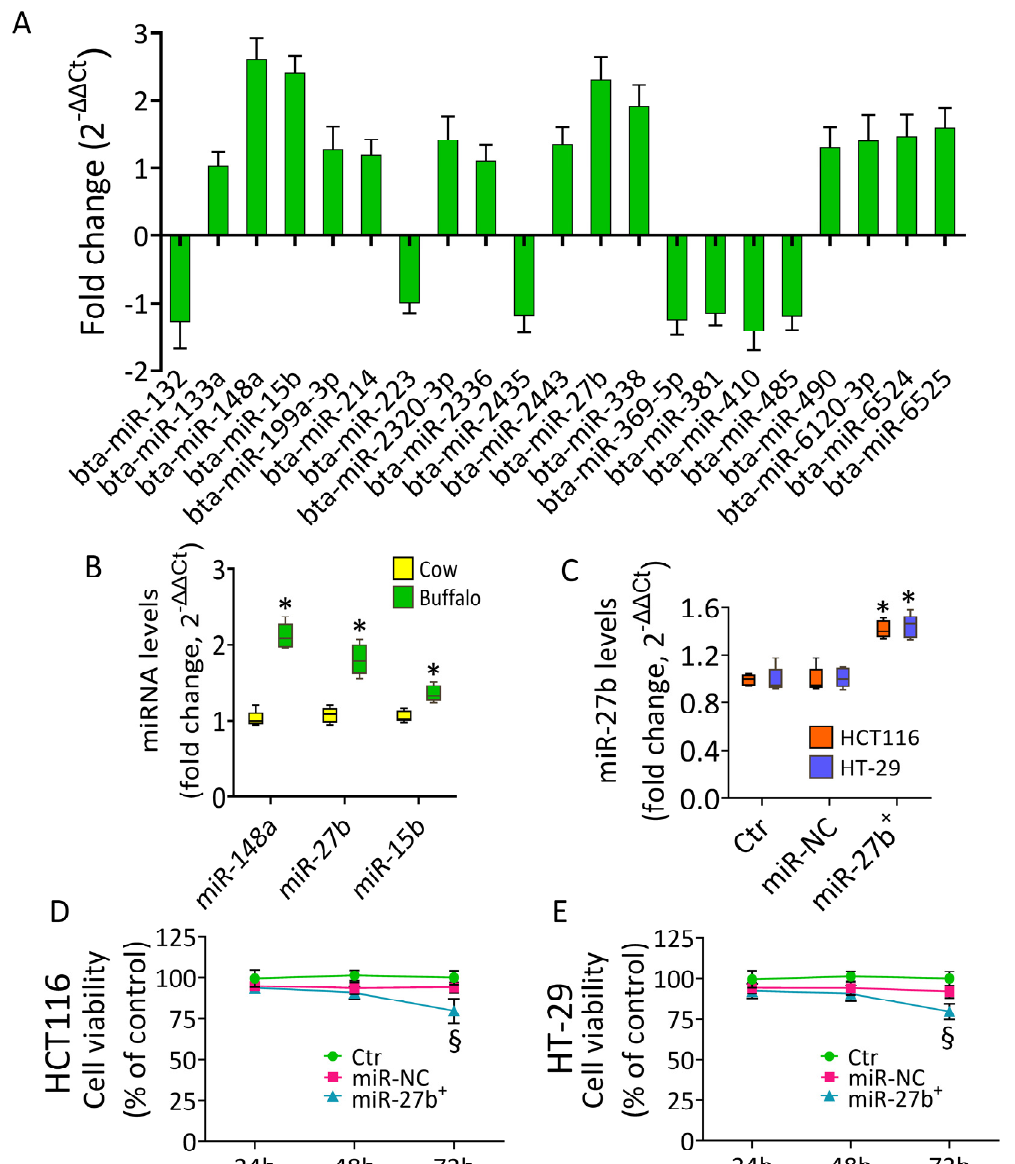
Figure 1. Expression pattern of miRNA in buffalo milk. ( A ) MiRNA expression profile of buffalo milk performed by a 96-well customized card analysis. Twenty-one miRNAs resulted differentially expressed in buffalo milk, compared to control bovine milk, with significant values p < 0.05. MiRNA levels are reported as bars representing the mean ± SD. ( B ) The relative expression of milk-derived miR-148a, miR-15b, and miR-27b was analyzed by qRT-PCR and normalized with Spike-In as endogenous control. MiRNA levels are reported as floating bars with line representing the mean ± SD. * p < 0.05 vs. cow milk. ( C ) The relative expression of miR-27b, analyzed by qRT-PCR and normalized with U6 as endogenous control, in HCT116 and HT-29 transfected with 30 nM mimic Negative Control (miR-NC) and miR-27b mimic (miR-27b + ). MiRNA levels are reported as floating bars with a line representing the mean ± SD. Cell Counting Kit-8 assay was performed in order to evaluate the cell viability of ( D ) HCT116 and ( E ) HT-29 cells. The transfection was performed using 30 nM mimic Negative Control (miR-NC) and miR-27b mimic (miR-27b + ) and viability expressed as % of control of n = 4 independent. Control cells (Ctr) were treated with the corresponding highest volume of HBSS-10 mM Hepes. * p < 0.05 vs. miR-NC; § p < 0.01 vs. miR-NC. Validation of miR-148a, miR-27b, and miR-15b levels, sharing homology score values greater than 100 with human counterparts (https://www.mirbase.org/), accessed on 21